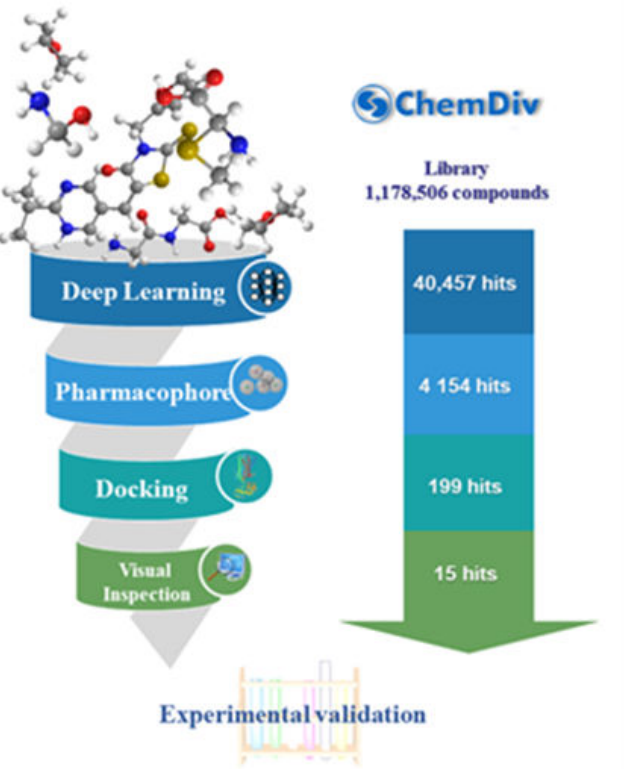
Figure 3. Workflow of the multi-step virtual screening of the ChemDiv database targeting CB2